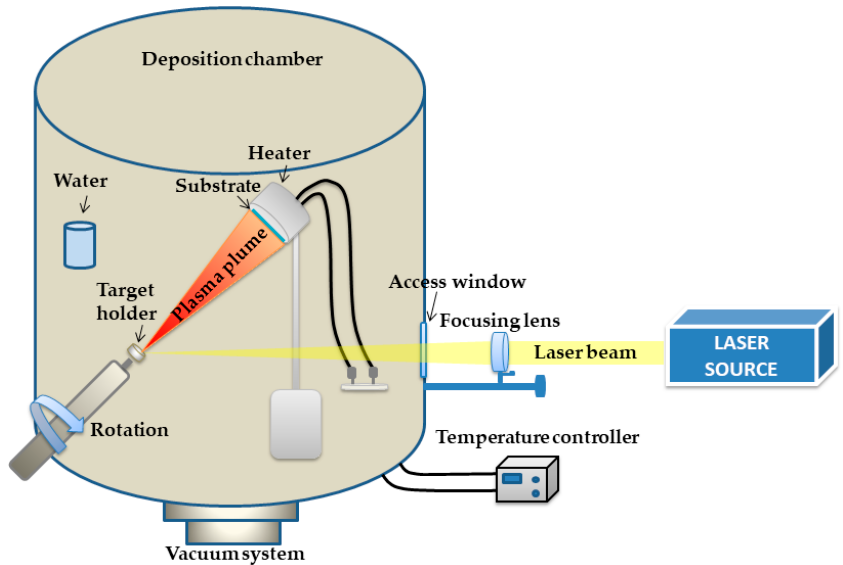
Figure 2. Schematic of an experimental set-up used for PLD synthesis of animal-origin HA coatings.